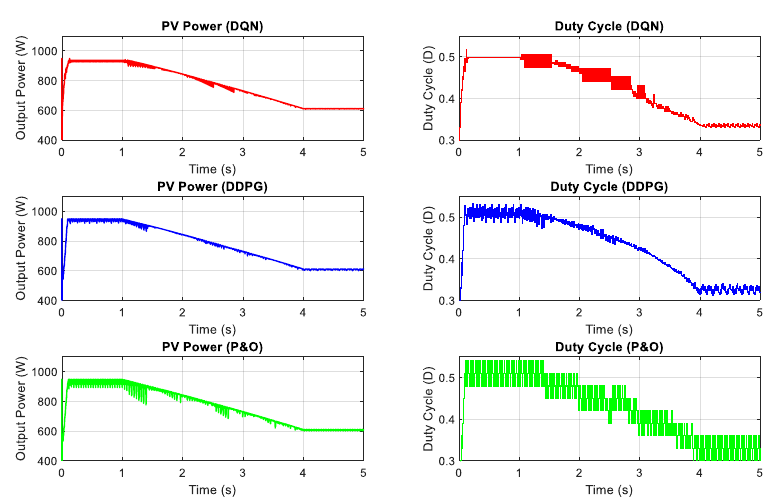
Figure 12. PV power under the change of both irradiation and temperature.